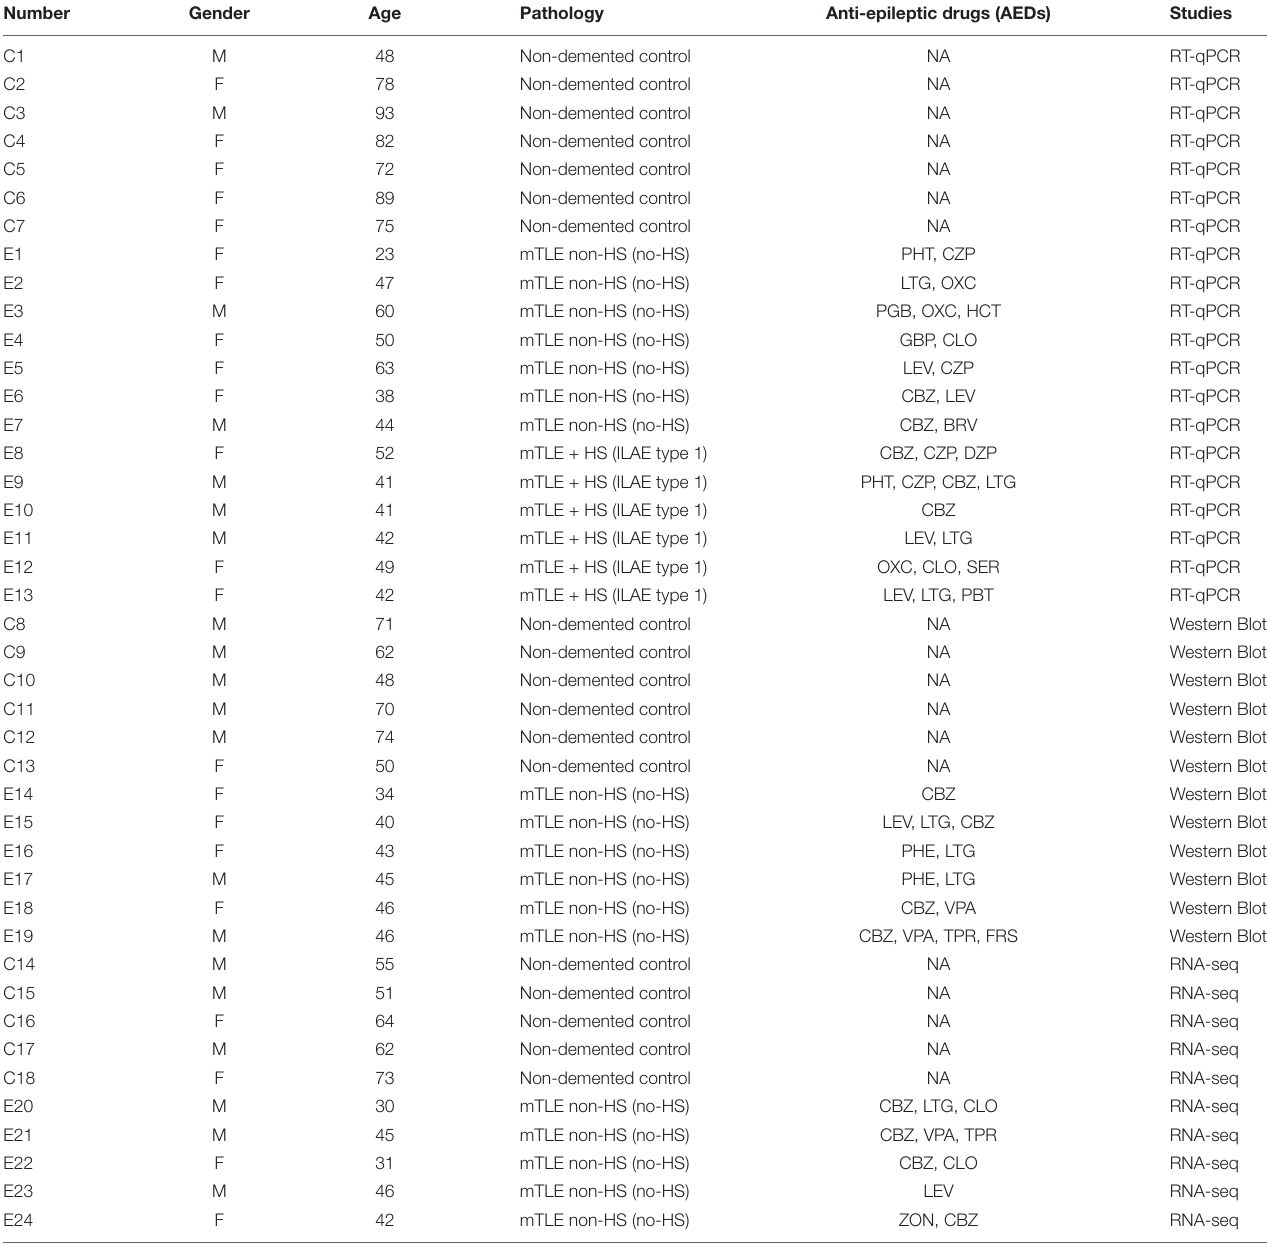
TABLE 1 | Details of control individuals and mTLE patients used in this